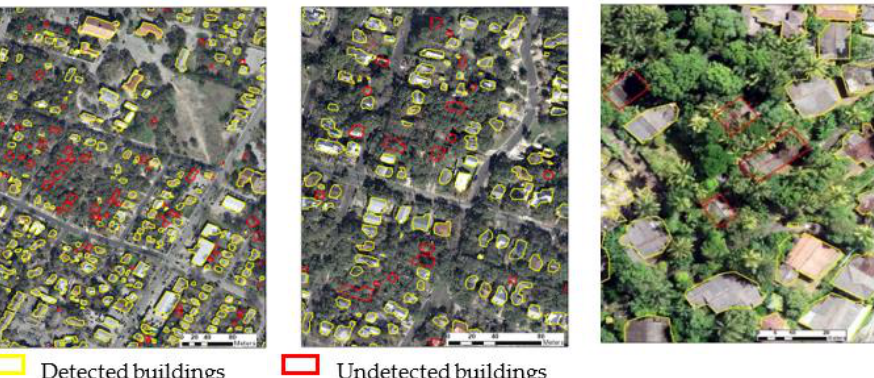
Figure 17. Undetected buildings due to being covered by trees.